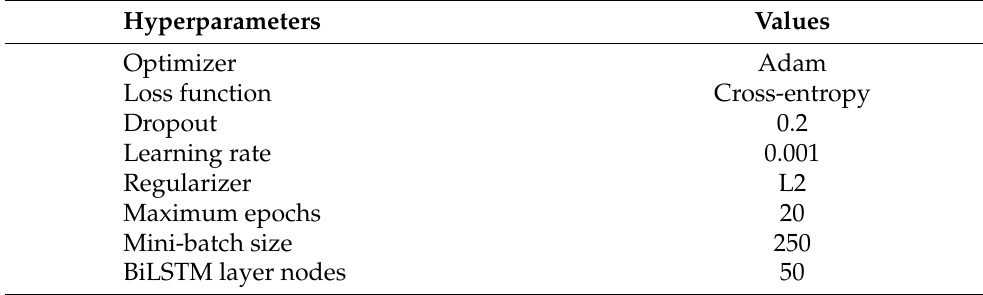
Table 3. Hyperparameter